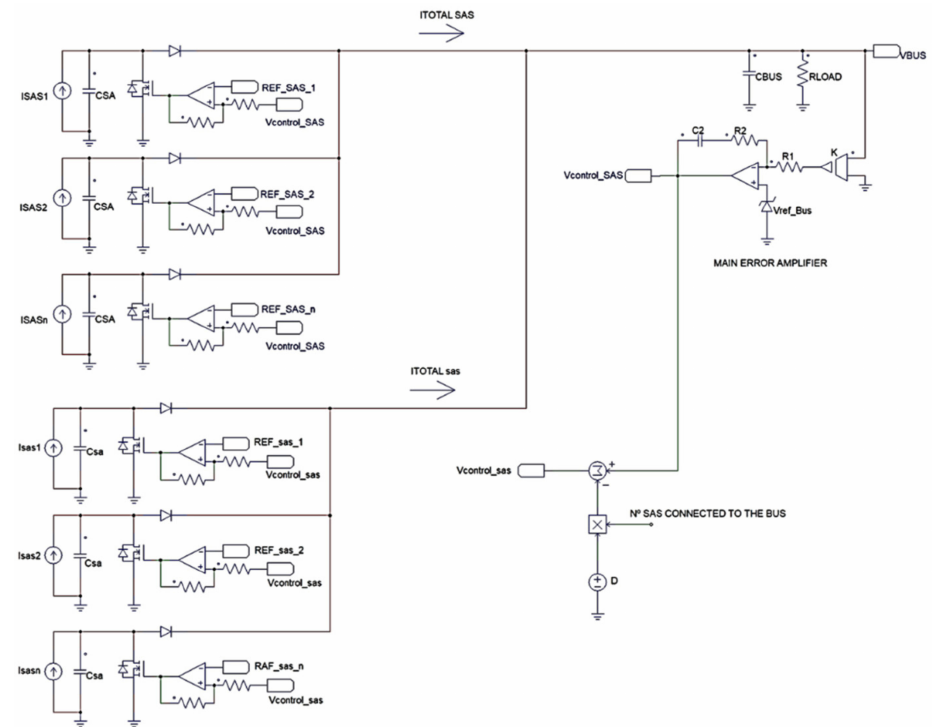
Figure 3. Proposed solar array